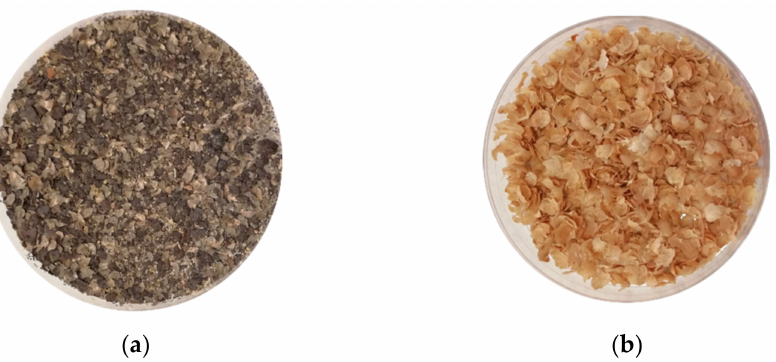
Figure 1. Colour of chickpea hull: ( a ) dark brown Apulian black chickpea hull; ( b ) yellowish kabuli chickpea